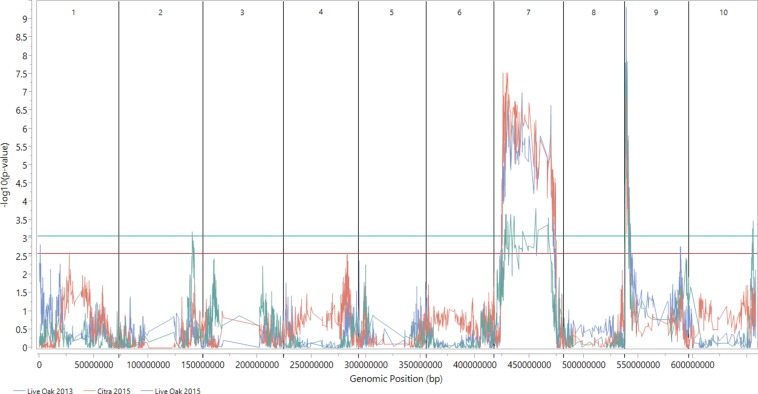
Association map of anthracnose resistance in the mapping population phenotyped in three environments. The graph shows the degree of association between the markers and the disease phenotype. The x-axis represents the genomic position, and the y-axis represents the –log10(p-value) obtained from Fisher’s exact test. A higher y-value indicates a stronger association between the marker at that position and disease resistance. The blue, red, and green lines represent the environments of Live Oak 2013, Citra 2013, and Live Oak 2015, respectively. The vertical black lines separate the 10 chromosomes, while the horizontal lines mark the FDR significance thresholds of 5%, with the colors corresponding to the environments; the FDR-lines for the two 2013 environments are indistinguishable from one another in this figure.